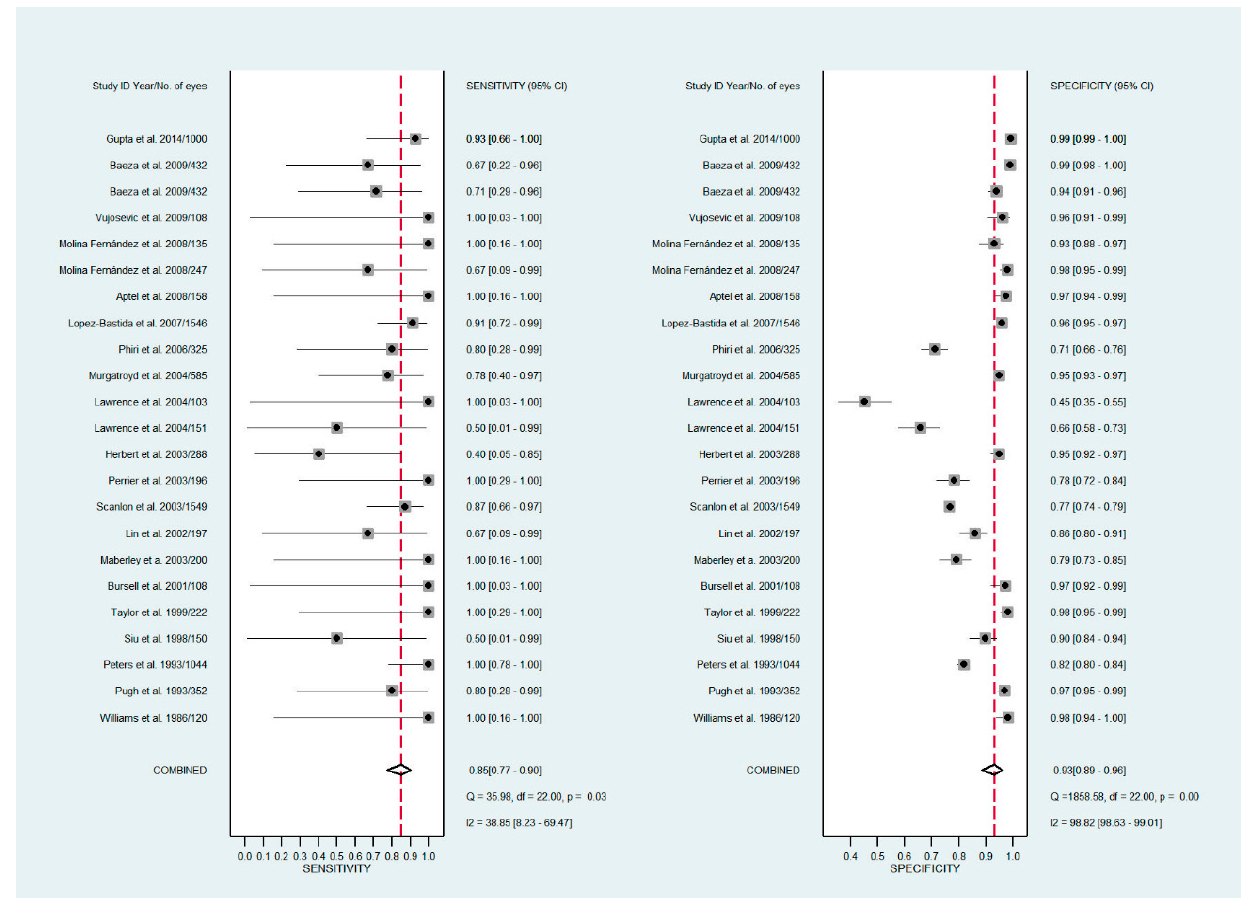
Figure 4. Forest plots for the sensitivity and specificity of non-mydriatic fundus photography.